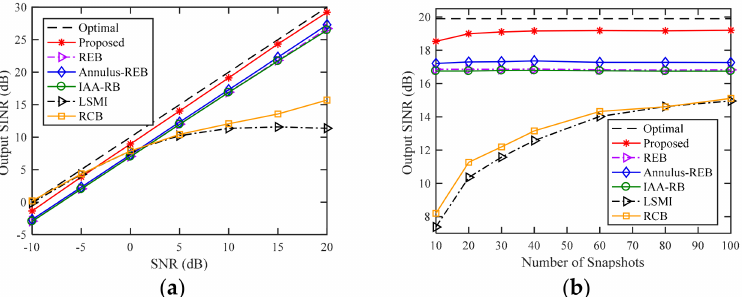
Figure 3. Output SINR versus ( a ) SNR ( b ) number of snapshots with incoherent local scattering and random sensor displacement.